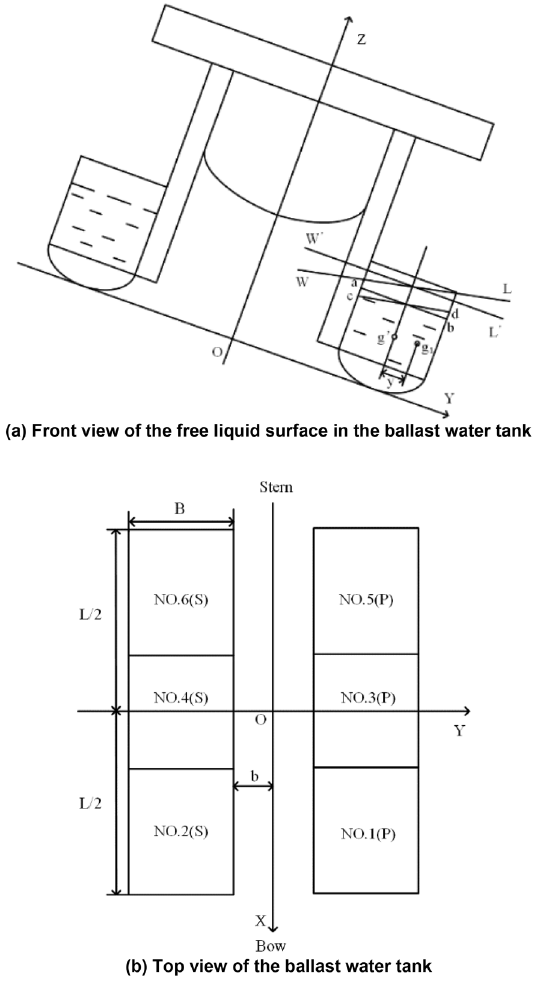
Figure 6. Influence of the free liquid surface stability in the ballast